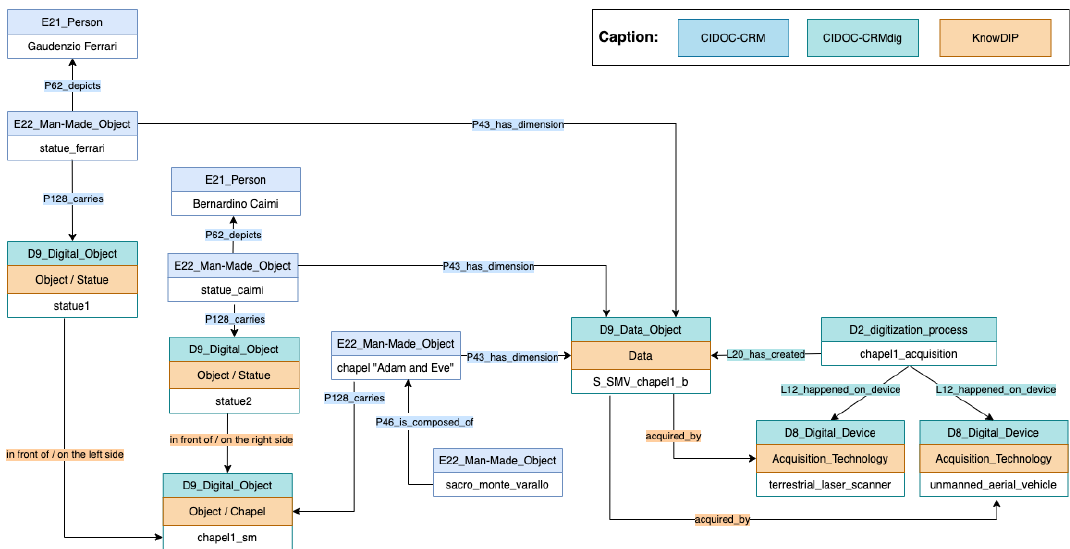
Figure 7. RDF representation of the chapel “Adam and Eve” acquisition in the Sacro Monte